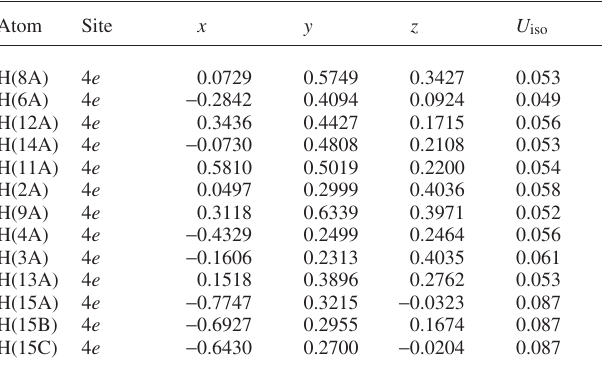
Table 2. Atomic coordinates and displacement parameters (in Å 2 )